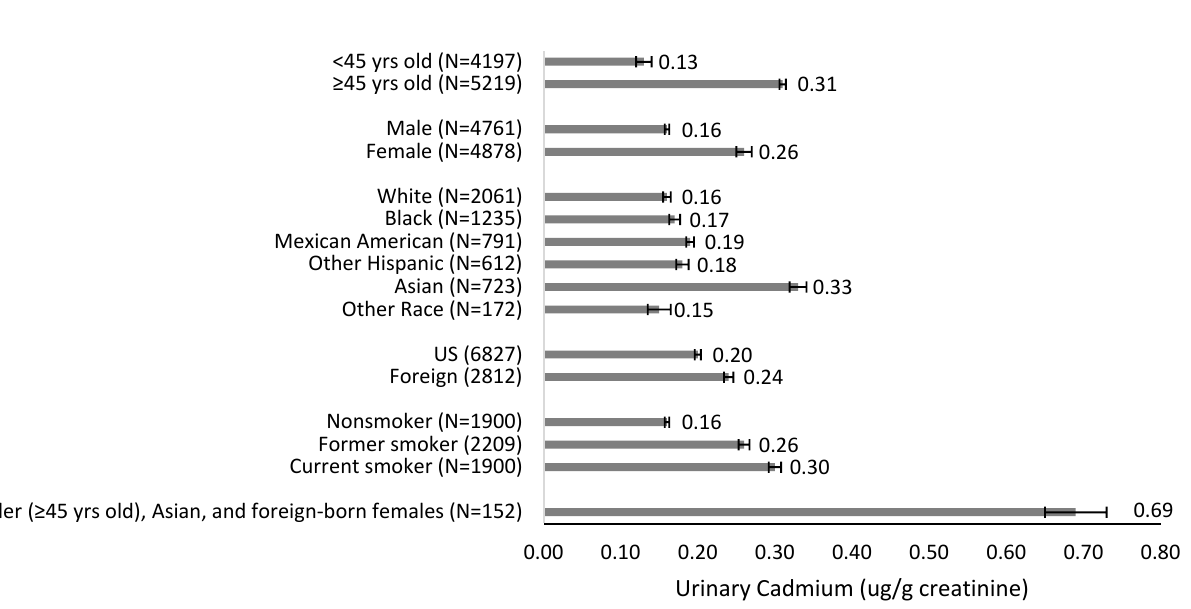
Figure 2. Geometric mean value of urinary cadmium levels ( µ g/g creatinine) by age group, gender, race/ethnicity, nativity, and smoking status. Table 2. Association between the patients’ characteristics and geometric mean values of urinary cadmium levels.